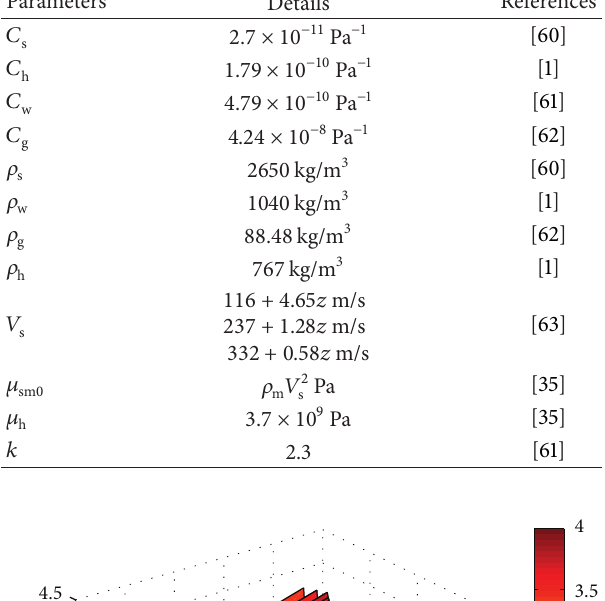
Table 1: Values of the main parameters of the gas hydrate and free gas model of the TPT.